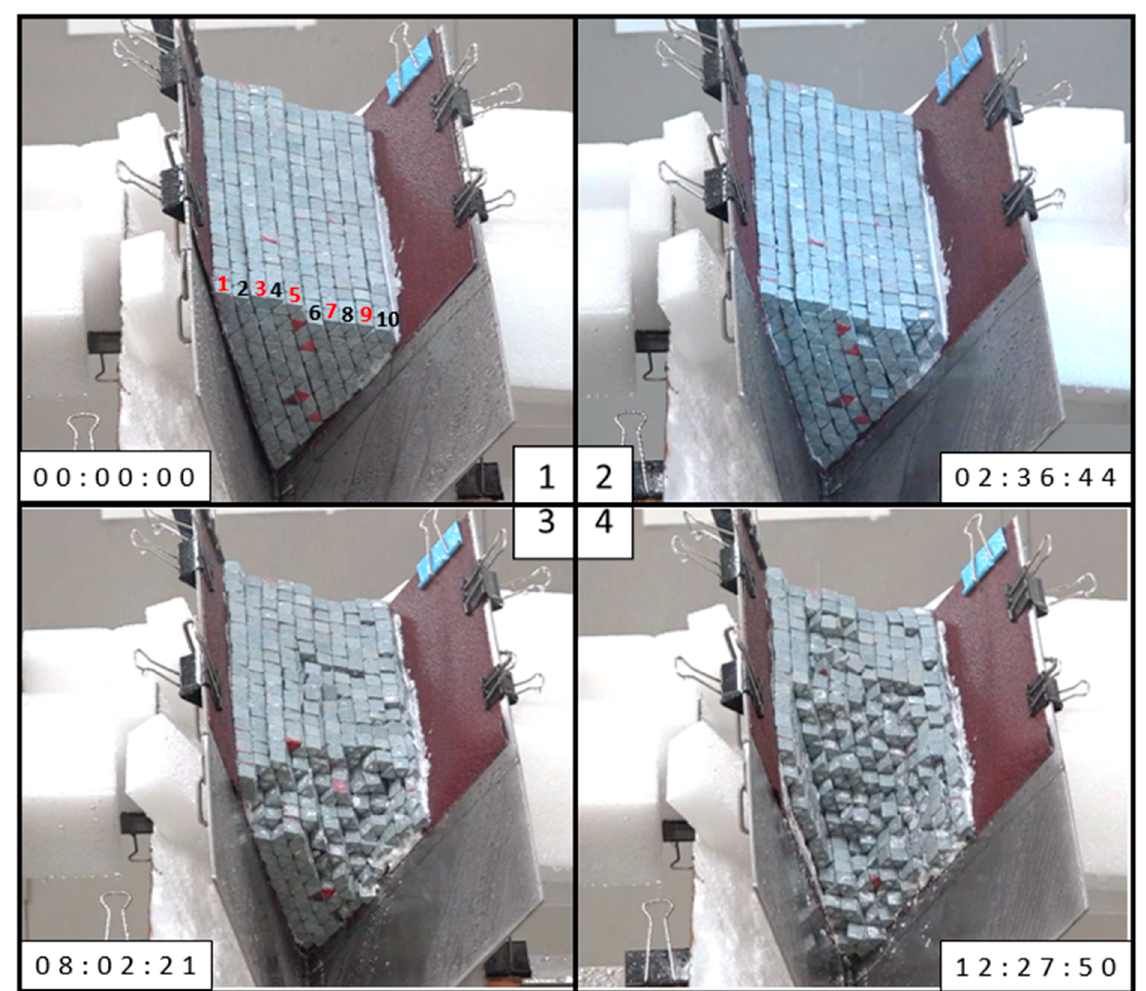
Figure 6. Physical model A ( i a = 40° and ω 1 = ω 2 = 25°). The duration of the Model B ( i a = 40° and ω 1 = ω 2 = 45°) test was 12 h 26 min 23 s (Figure 7). At first (initial slight deformation stage at 00:00:00–01:29:00), surface water in- filtrated the model via weak planes, softening the model and causing slight deformation.